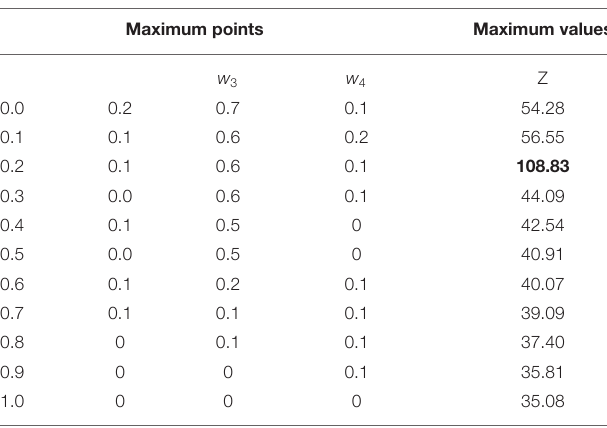
TABLE 2 | The maximum values of